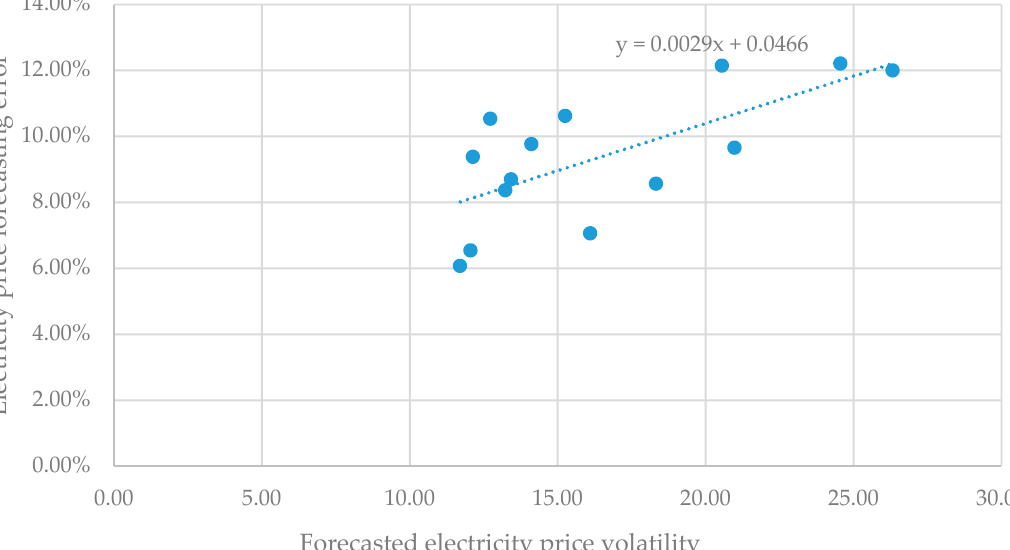
Figure 13. Correlation between forecasting error and price volatility in the 1st forecasting interval.